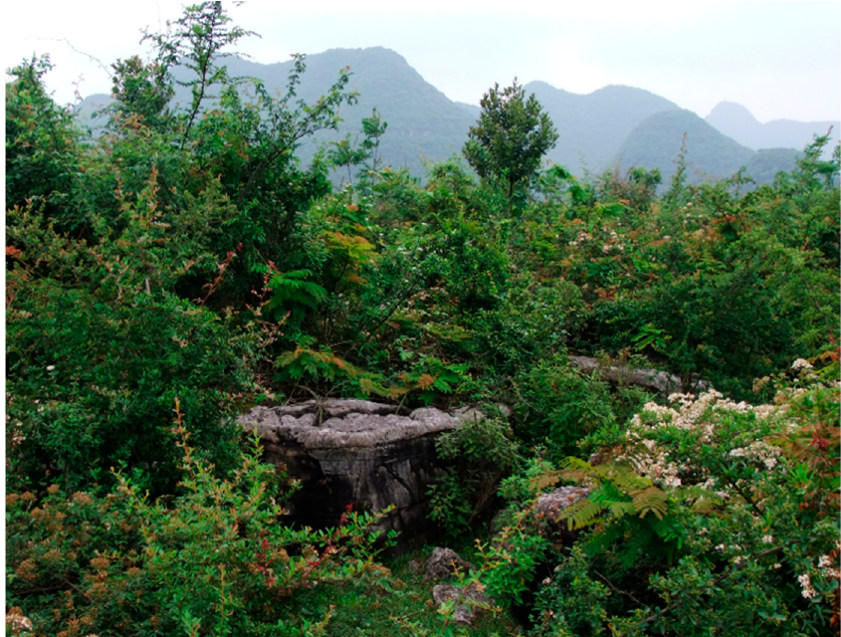
Figure 3. Example of a shrub–arbor forest transition (FS) investigated in this study.